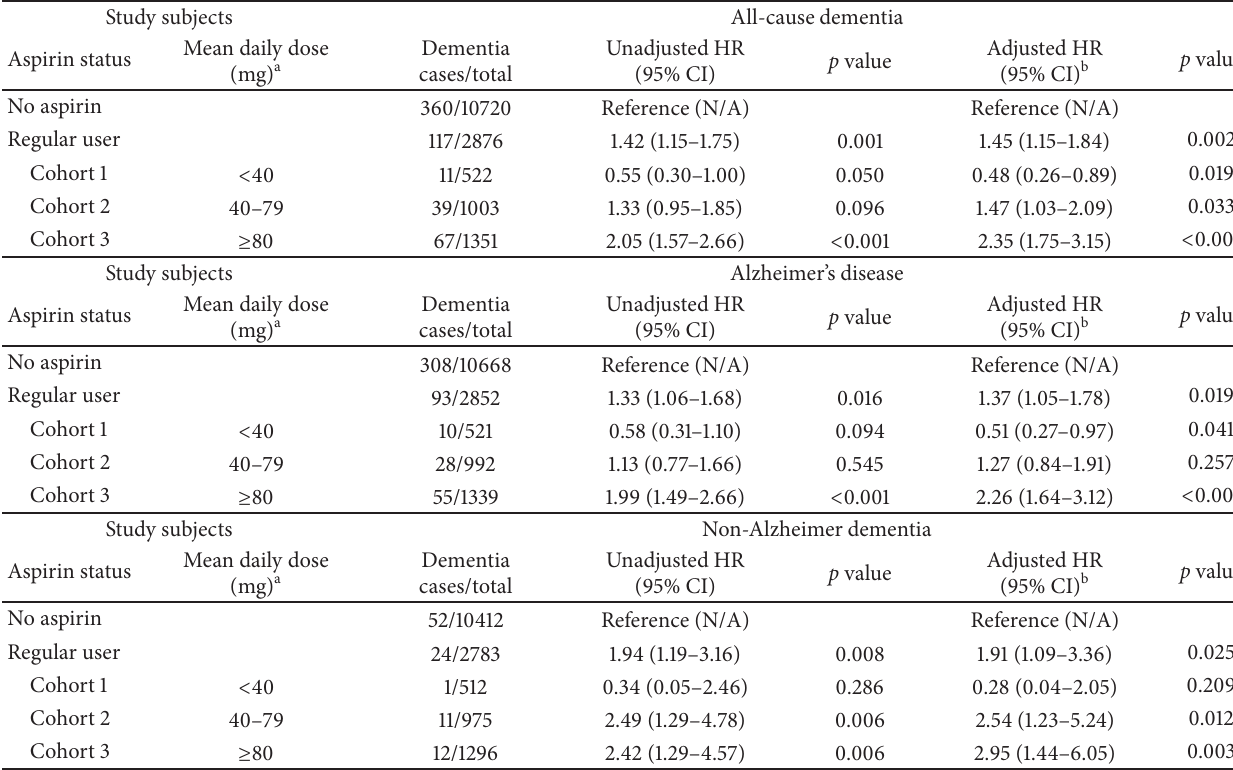
Table 2: Risk of Alzheimer’s disease, non-Alzheimer dementia, and all-cause dementia among T2DM patients who regularly use